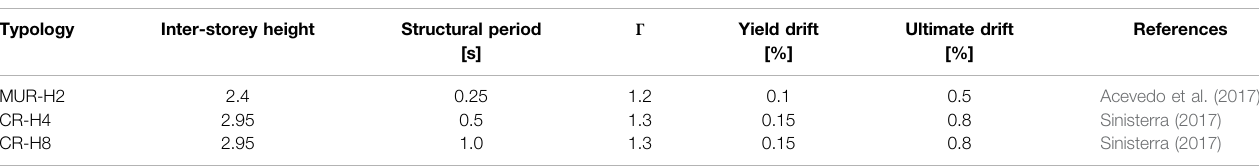
TABLE 1 | Main characteristics of the different typologies considered in the analysis.